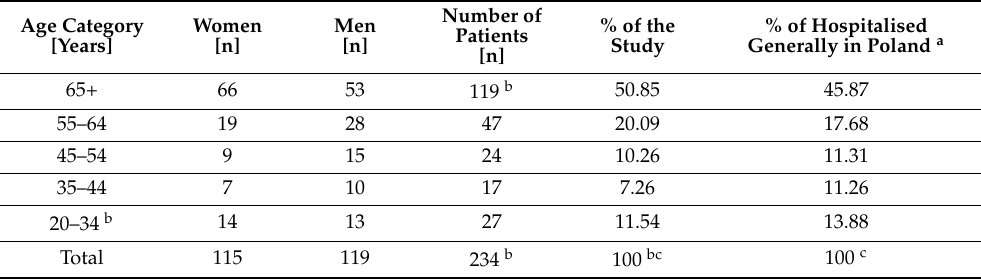
Table 2. Age and sex characteristics of the studied group.